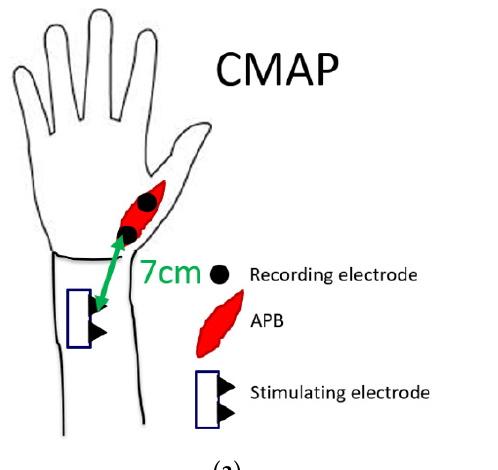
Figure 1. Ultrasound measurement of median nerve cross-sectional area. Cross-sectional area was measured as the only parameter for the image analysis. Measurement of the median nerve cross- sectional area was performed at the wrist crease level. The median nerve was outlined, and its area was calculated.